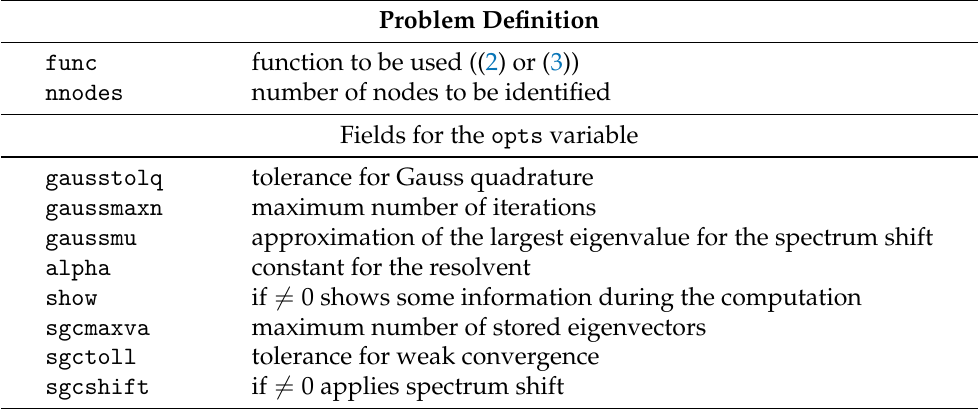
Table 2. Problem definition and options.